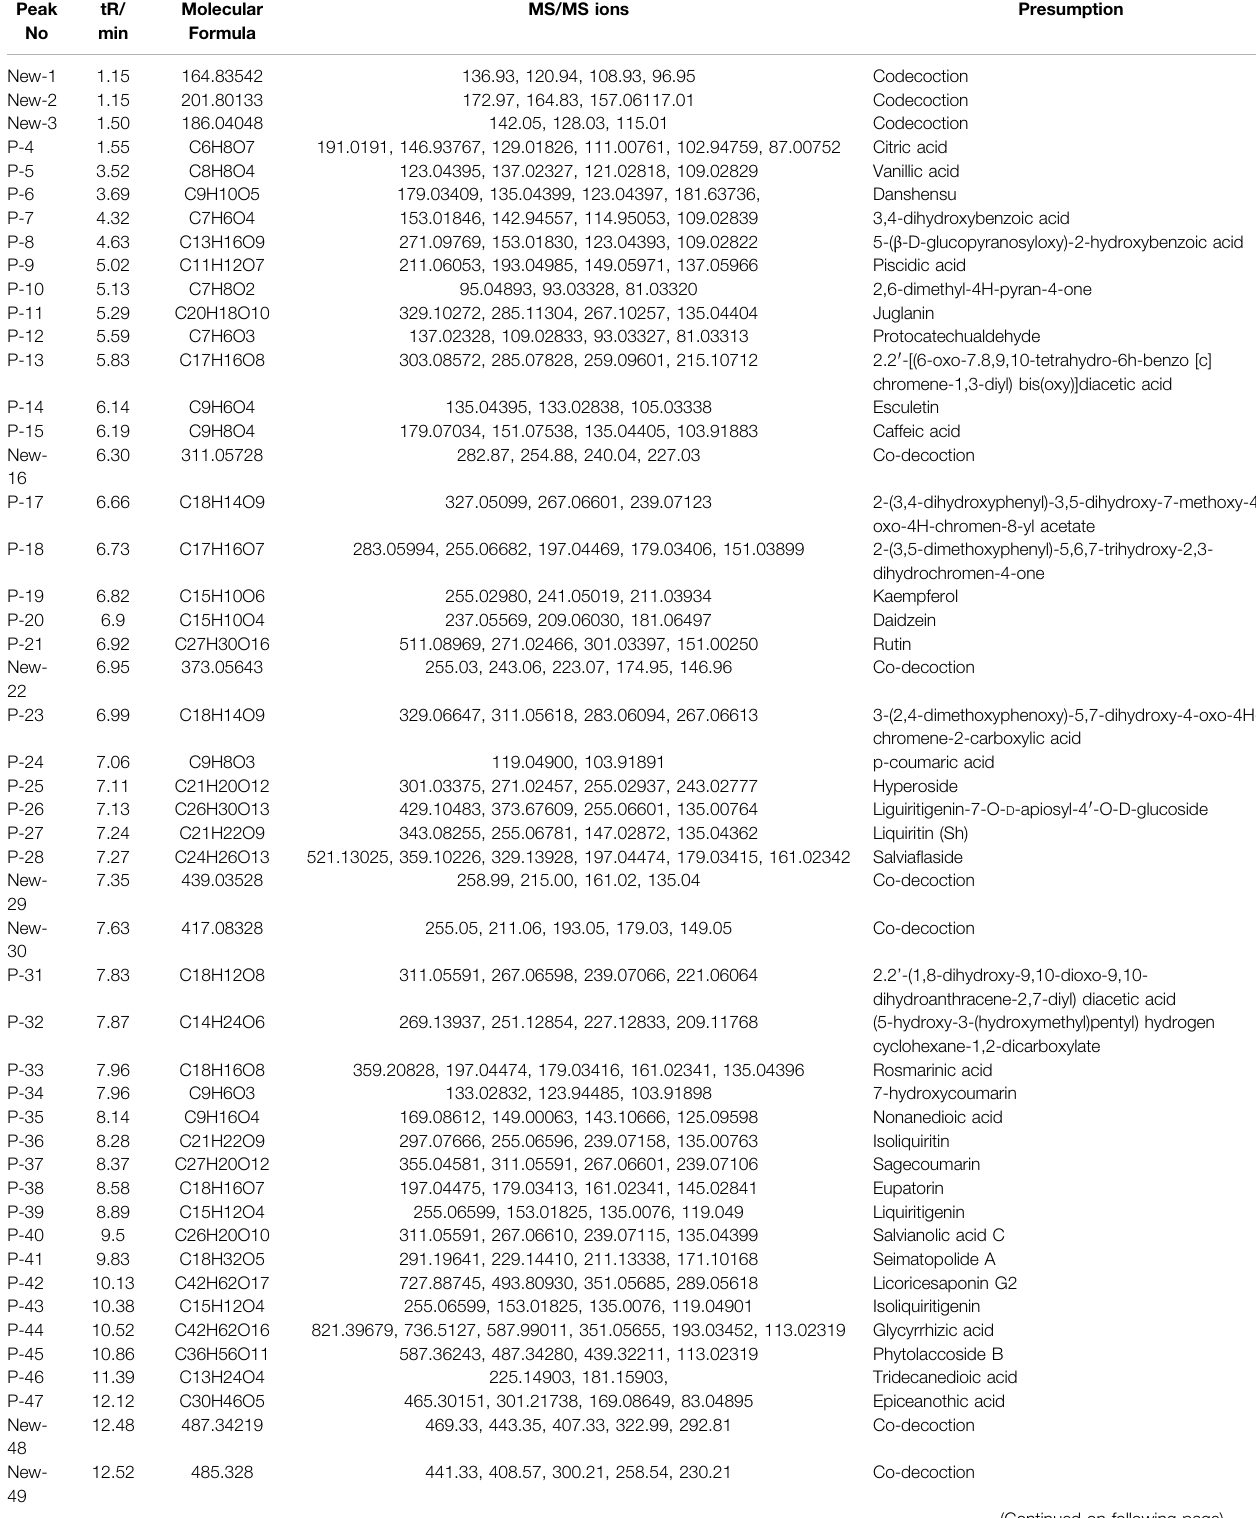
TABLE 4 | Known compounds absorbed into the blood from Pinellia ternata (Thunb.) Makino , Prunella vulgaris L. prototype ingredients, and the new generated ingredients by